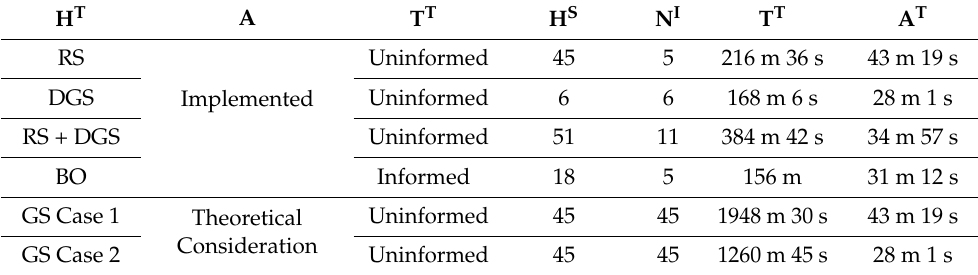
Table Legend: H T : HPO Technique, A: Aspect, T T : Type of Technique, H S : Hypercube or Search Space Size, N I : Number of Iterations, T T : Training Time, A T : Average Time Per Hyper-parameter Evaluation, GS Case 1: Considering the average time of RS, GS Case 2: Considering the average time Table 8. Training time consumption by various HPO techniques.